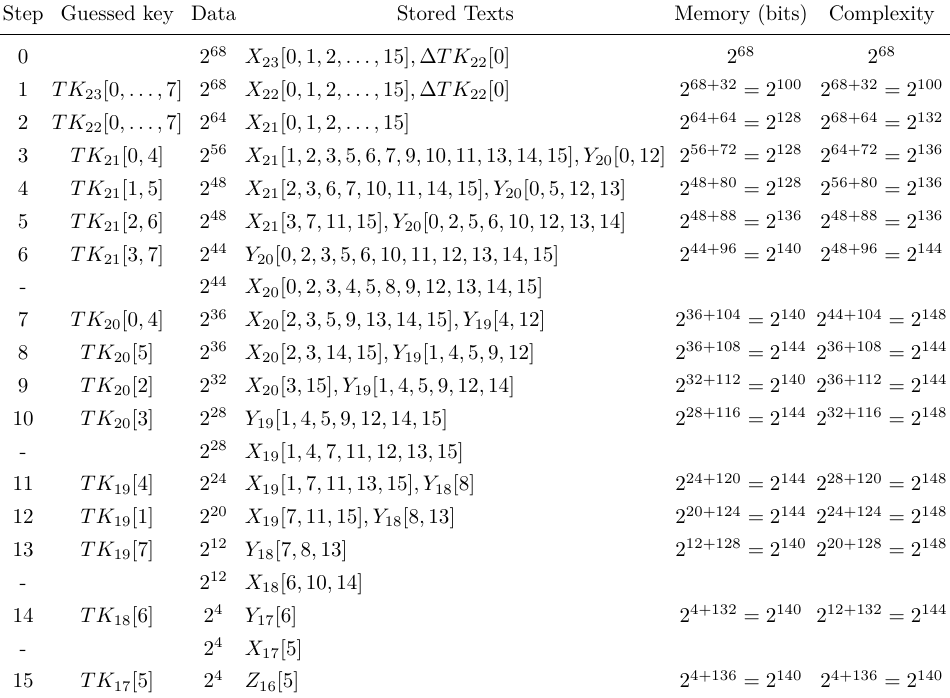
Table 4: Procedure for the key-recovery of L Z 16 [5] on Skinny